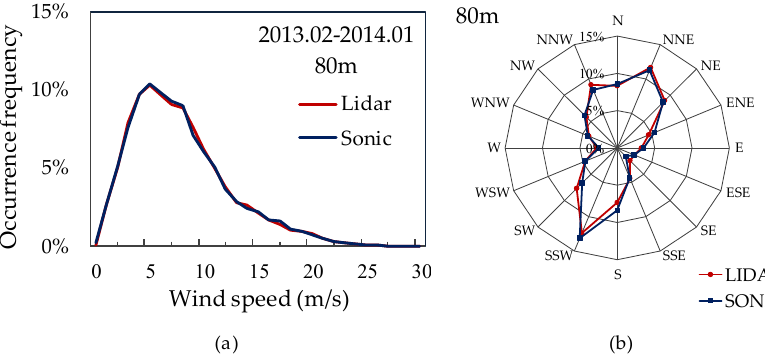
Figure 3. ( a ) Frequency distributions of wind speed at the hub height and ( b ) Wind rose at the height of 80 m.